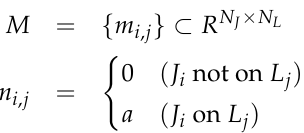
Table 1. The element a of LJ-matrix is determined depending on types and known/unknown of J i . J i Is Revolute Pair Prismatic Pair Known a = − 1 a = − 2 Unknown a = 1 a = 2 Known pairs mean fixed pairs or pairs that have been calculated their position already.